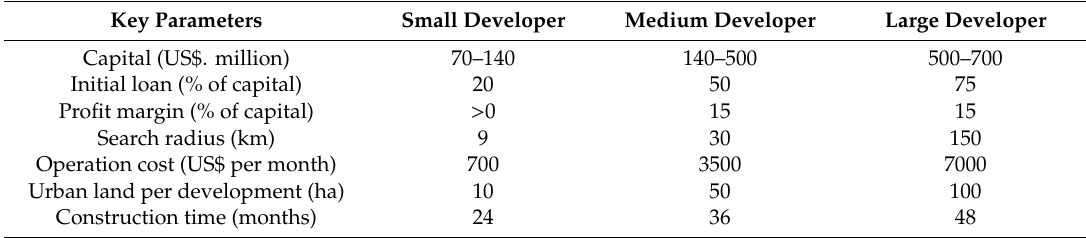
Table 1. Developers’ characteristics used to configure the initial state in the